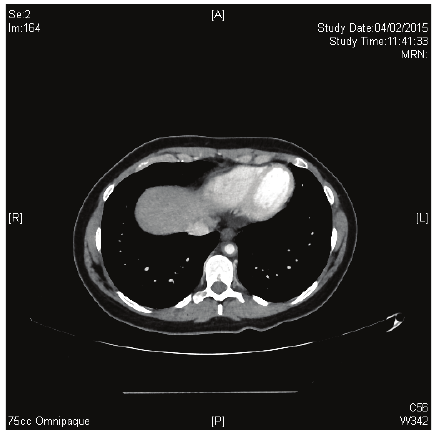
Figure 1: CT angiography revealing circumferential mural thicken- ing of the lower part of the thoracic